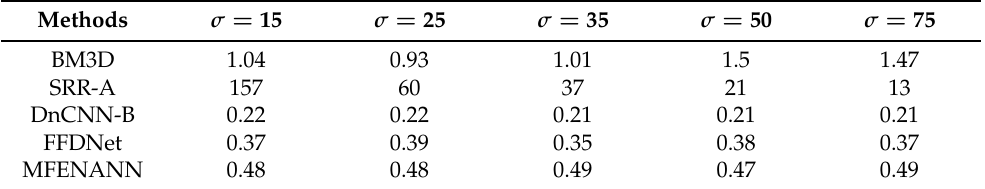
Table 9. The average runtimes (s) of several state-of-the-art methods for images in “Set12” at noise levels of 15, 25, 35, 50 and 75. The bold numbers are the largest ones at each corresponding noise